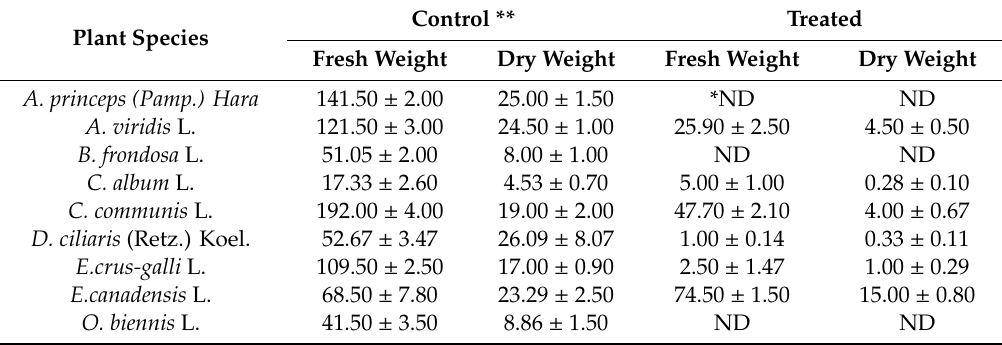
Table 4. Allelopathic e ff ects of M. sacchariflorus extract on fresh weight and dry weight of broad-leaved weeds and grass